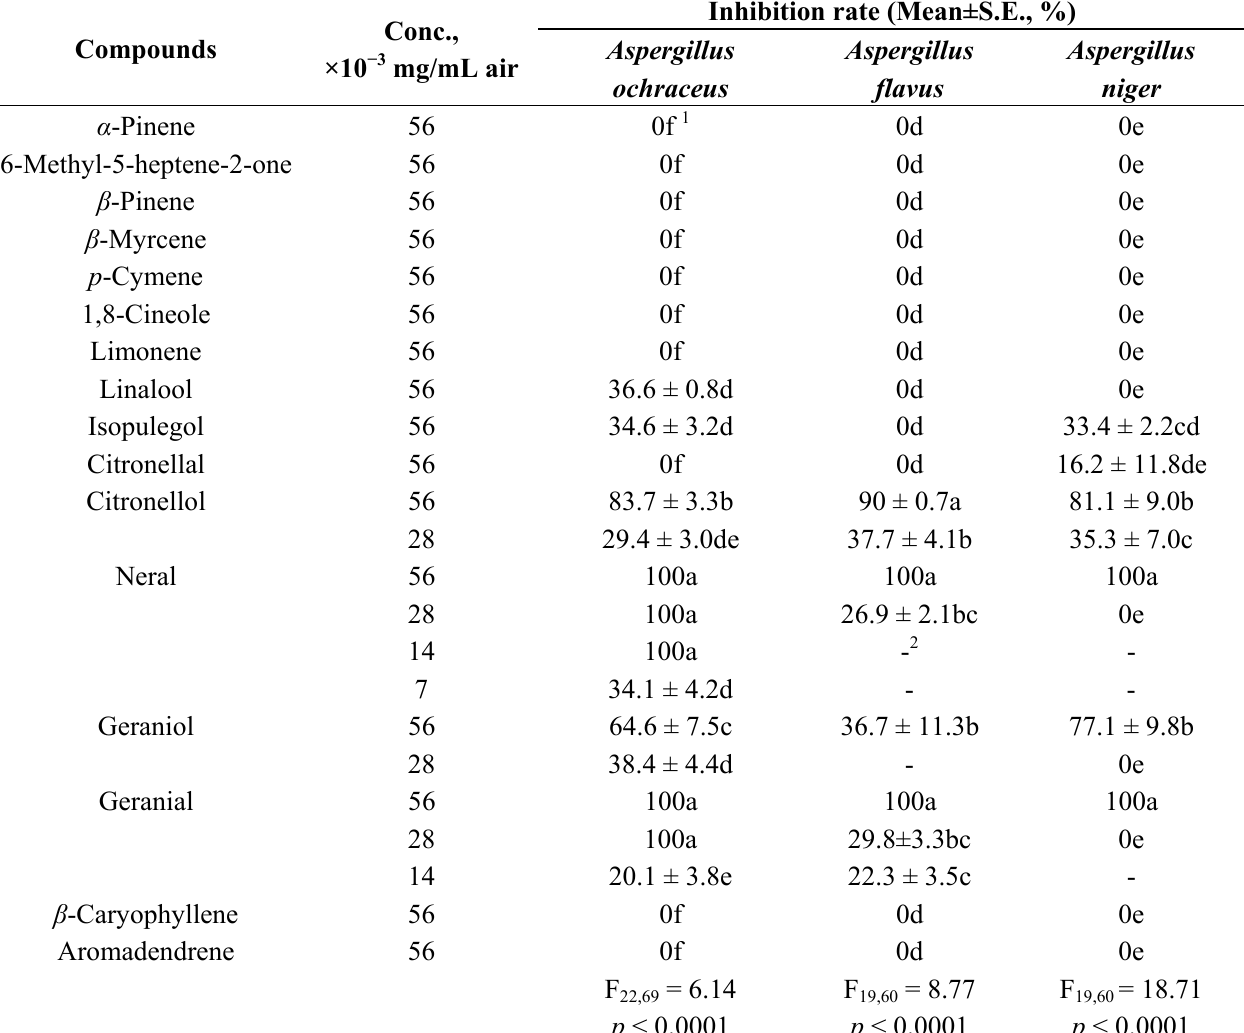
Table 3. Fumigant antifungal activity of compounds identified in Leptospermum petersonii essential oils against three Aspergillus